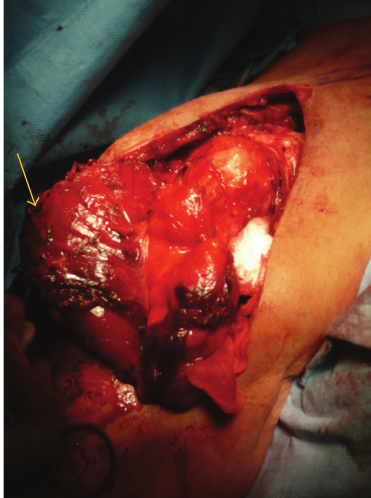
Figure 1: The deltoid muscle reflected inferiorly (arrow) and the lipomatous tumour exposed in the sub-deltoid space.